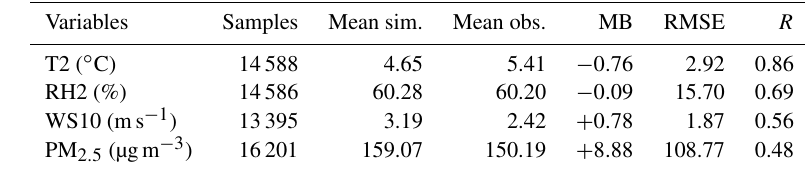
Table 3. Statistics for evaluation of model (EXP_CTL) performance against observations. Variables Samples